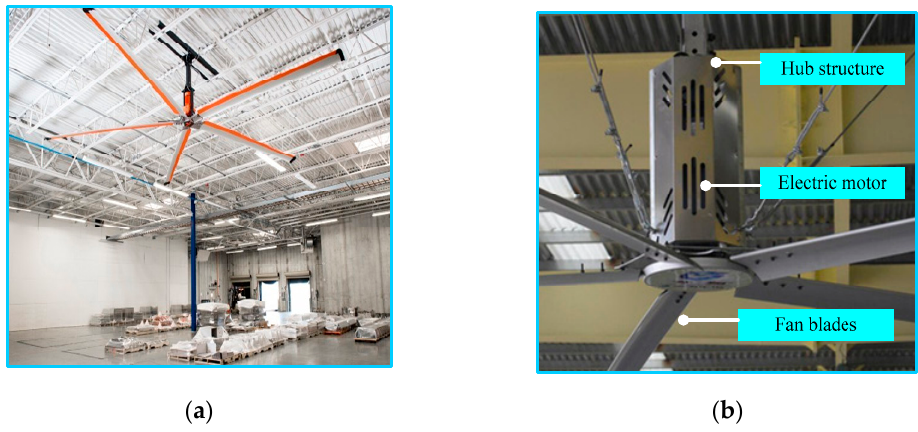
Figure 2. Monstrous fan ( a ) Physical condition [10] ( b ) Common structure.